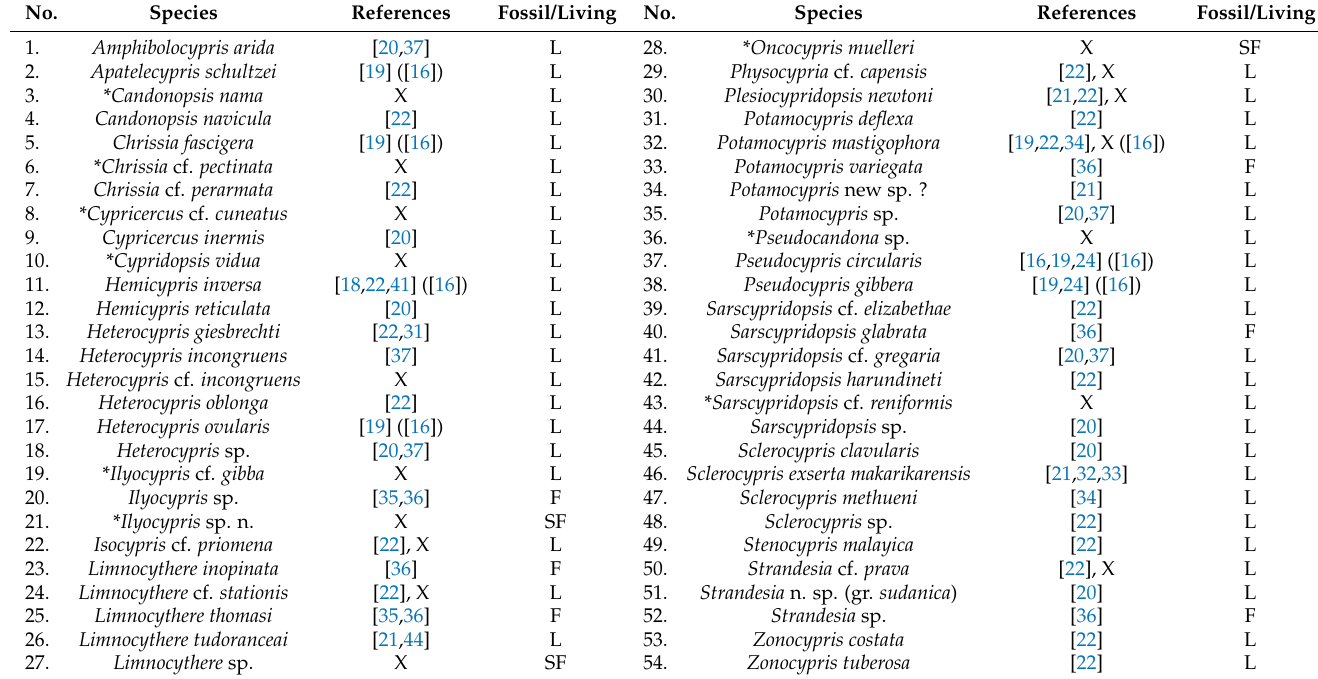
Table 1. Checklist of living (L), subfossil (SF = empty valves found in samples of wet surface sediment of existing waterbodies), and fossil (F = valves from Late-Pleistocene-Holocene sediments) non-marine Ostracoda from Botswana. Records of our own, unpublished field collection are denoted by X in the Reference column, and species with first records for Botswana are marked with an asterisk (*). Records included in the previous checklist of Ostracoda of the region of Southern Africa [16] are indicated in the brackets ([16]) after the original